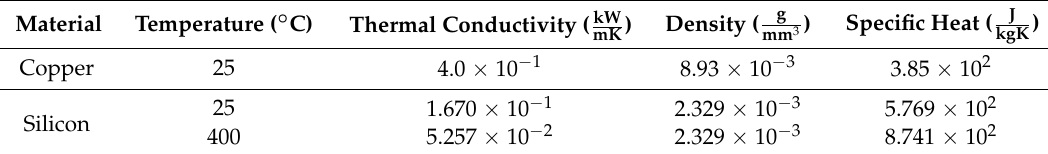
Figure 4. Thermal loading and unloading steps. 3. Results 3.1. Concept and Preparation of the Gradient Composites In this study, the thermal conductivity of a gradient composite based on an epoxy-amine resin composed of DGEBA and DETA was investigated. For the preparation of the test specimens, 10 wt % of alumina submicroparticles (diameter of 200 nm) and 10 wt % of alumina nanoparticles (diameter of 20–30 nm) were dispersed homogenously in the epoxy resin using a high-shear mixer. Subsequently, the resin was cured at r.t. for 4 h. Due to their higher weight, the submicroparticles were expected to sediment during the curing reaction (Figure 5), while the smaller nanoparticles were expected to remain dispersed throughout the resin. Due to the sedimentation, a gradient of the particle distribution was expected to occur and, correspondingly, a gradient of the thermal conductivity over the height of the specimen. In order to quantify the gradient of the thermal conductivity, the cured composite specimens with heights of 10 mm were cut into layers with a thickness of approximately 800 μ m using a microtome. The thermal conductivity of each individual layer was measured with a laser flash analysis system. Figure 5. Schematic overview of the concept and the preparation of gradient composites containing a mixture of nano- and submicron-scaled particles.